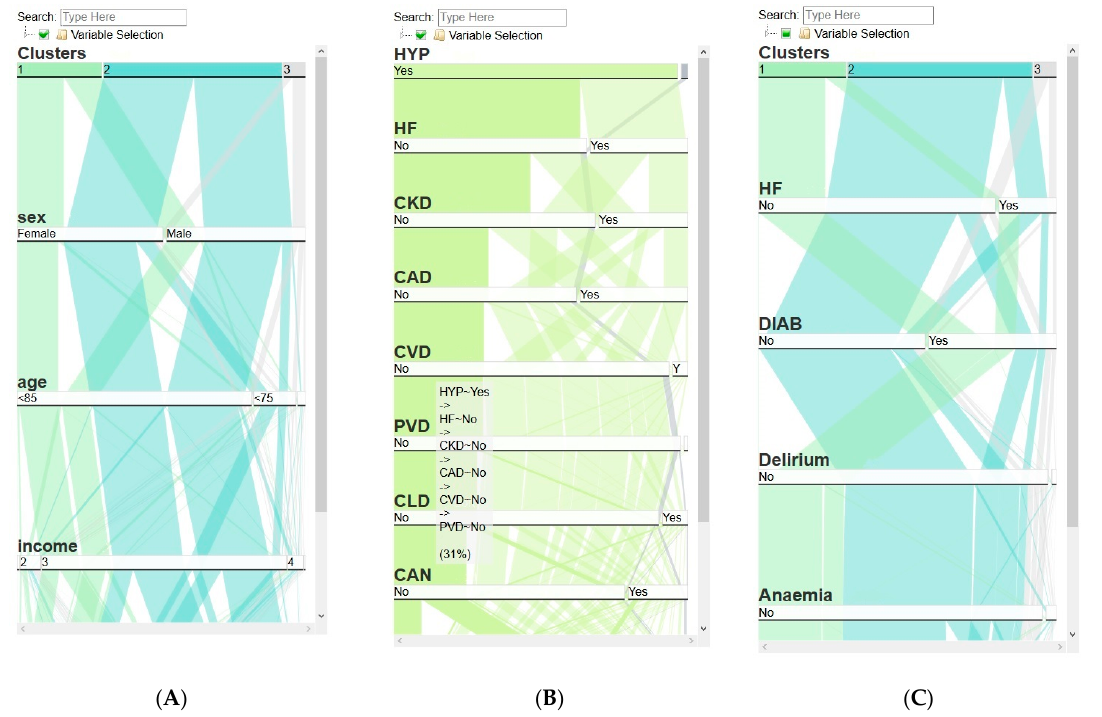
Figure 9. Showing the overview of the frequency subview, which shows the distribution of ( A ) different clusters and demographics, ( B ) all the comorbidities within a particular cluster, and ( C ) clusters and some user-selected features.